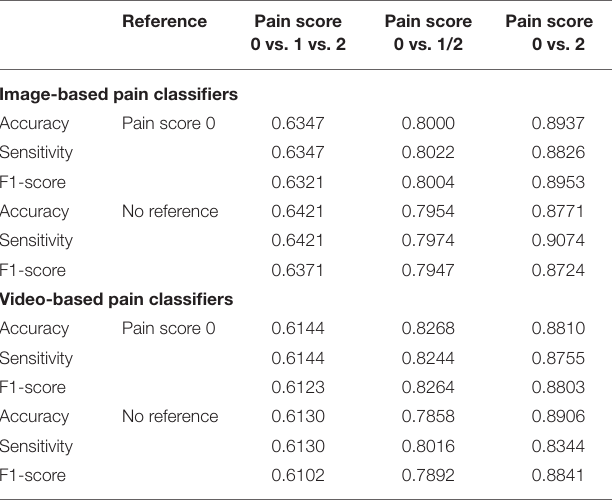
TABLE 4 | Accuracy of proposed image- and video-based pain classifiers with and without